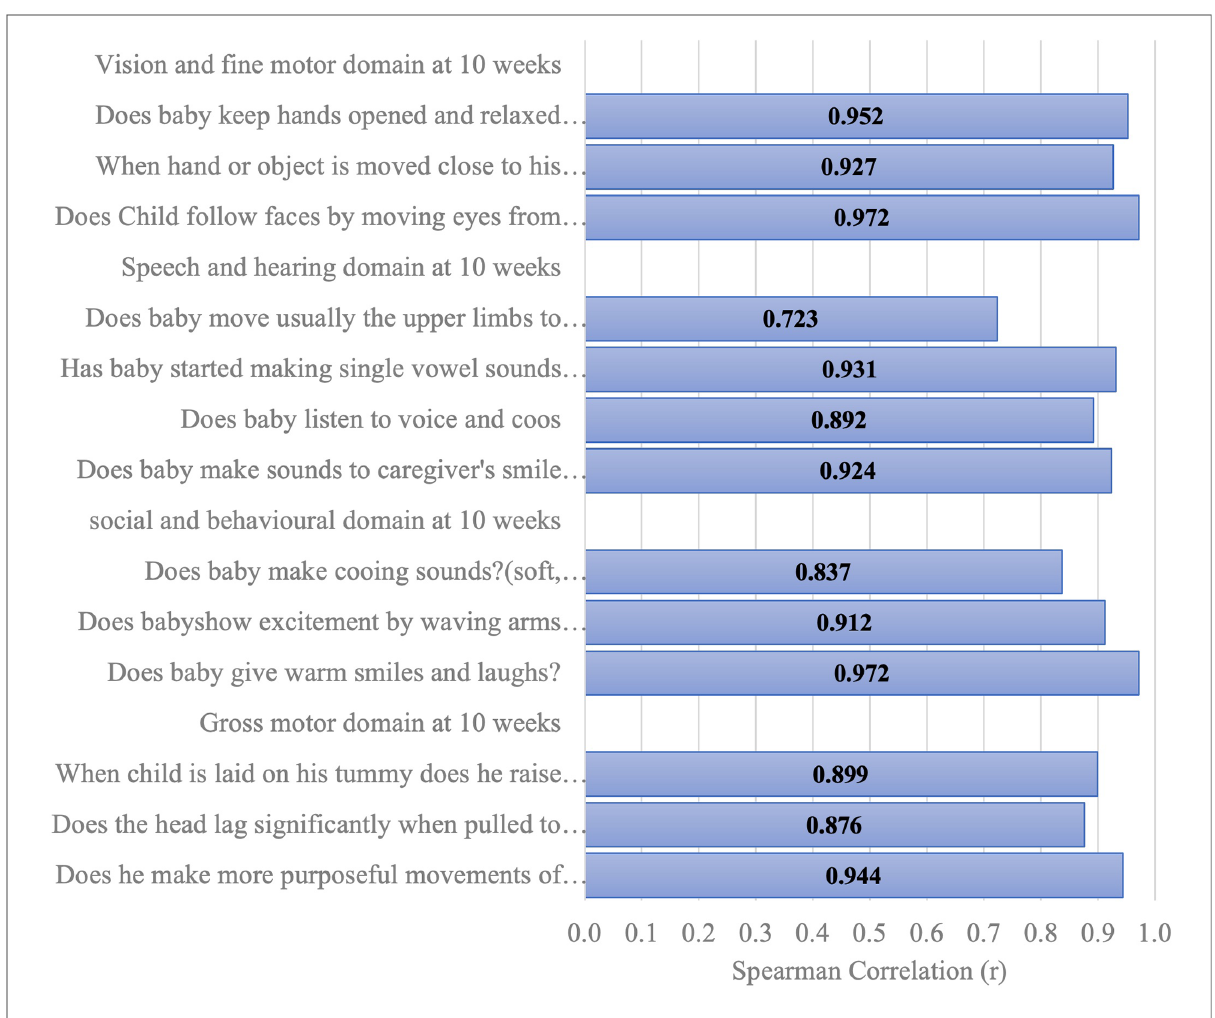
FIGURE 7 Spearman correlation coef fi cient of the ISDS scores of two assessors of the same participants aged 10